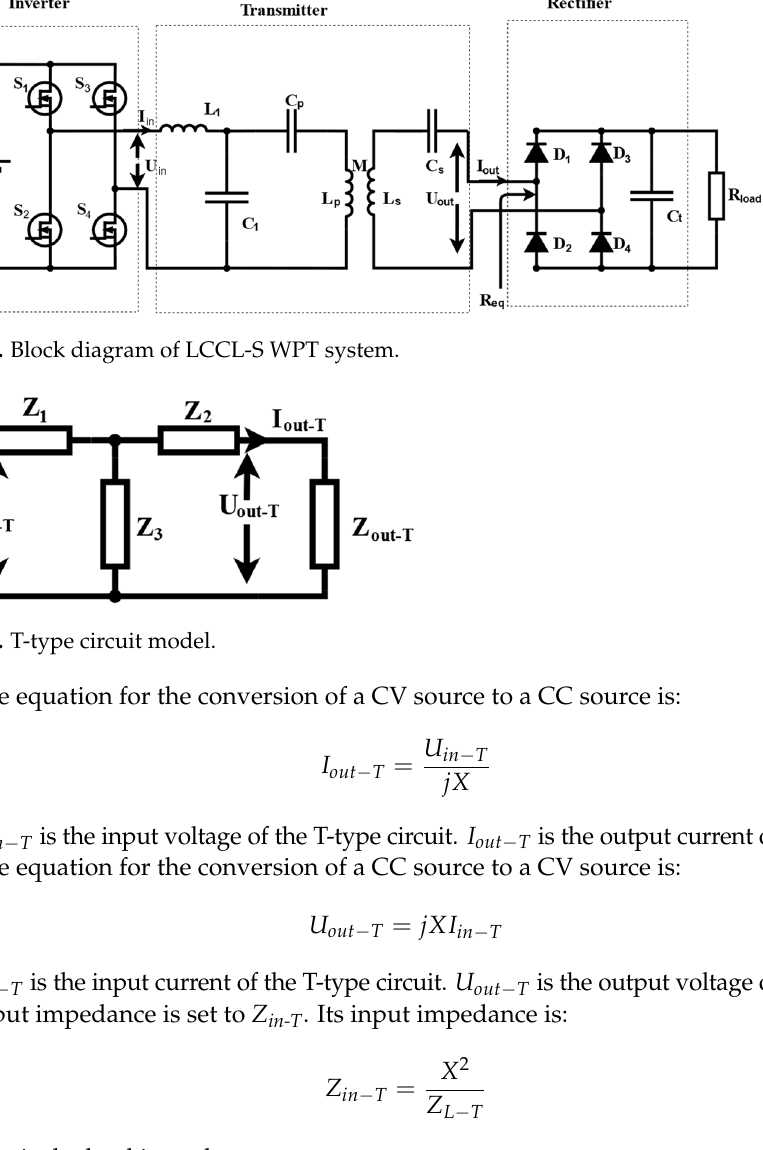
Figure 1. Block diagram of LCCL-S WPT system.